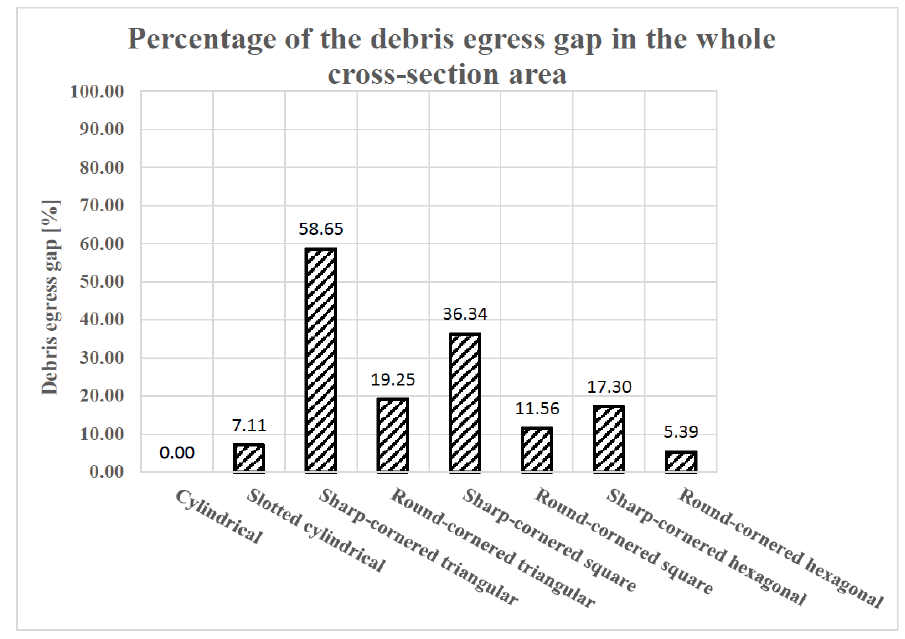
Figure 4. The percentage of debris egress gaps with respect to the whole cross-sectional areas.